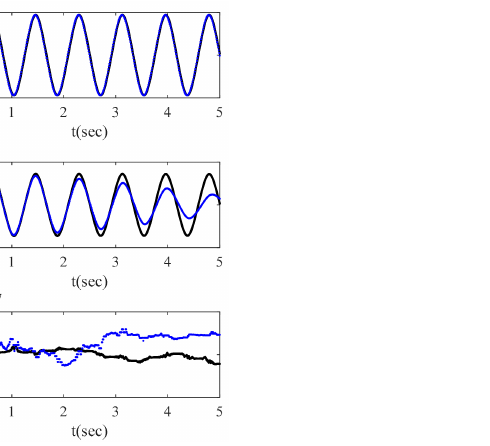
Figure 26. The angular velocity results under Lie algebra expression.